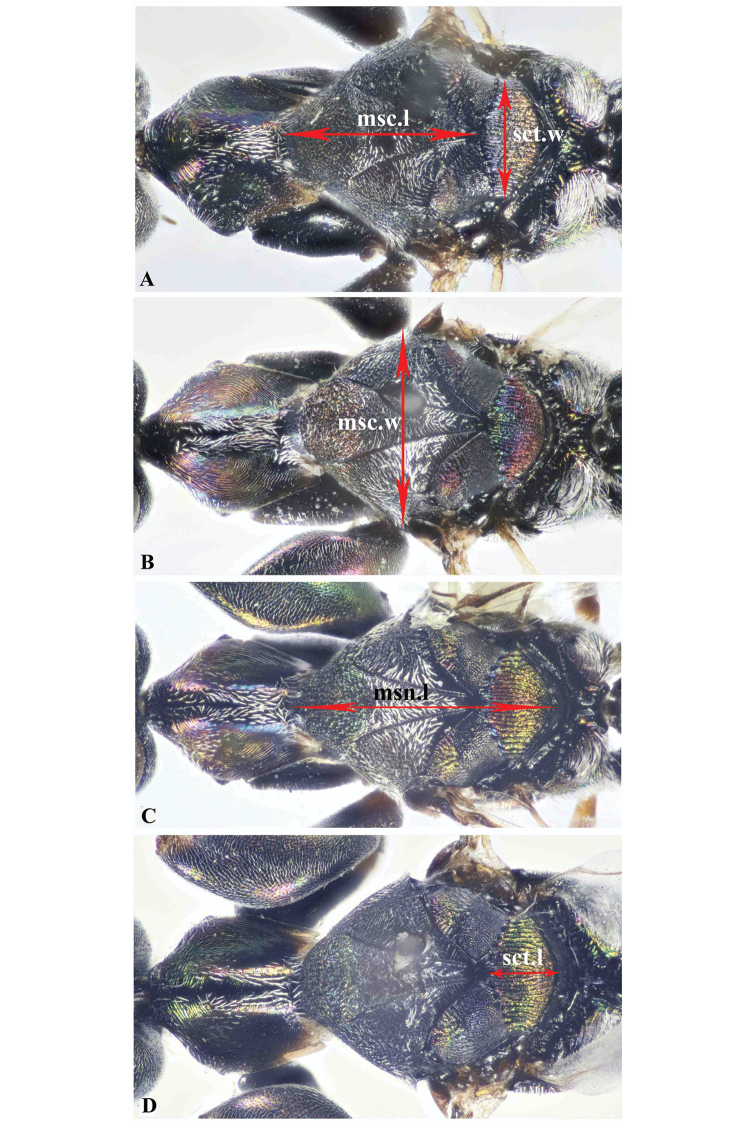
Dorsal aspect of mesosoma, Holotype AOodera
arabica sp. nov. BOodera
omanensis sp. nov. COodera
rapuzzii sp. nov. DOodera
similis sp. nov.